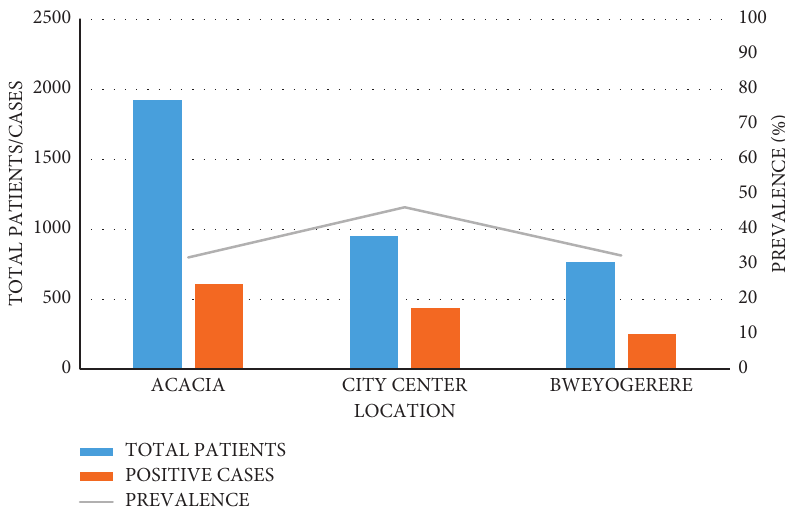
Figure 5: Clinic-specific overall